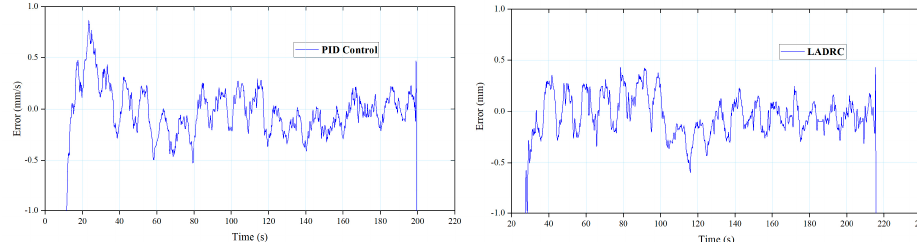
Figure 22. Speed error of cylinder #2 during unfolding.